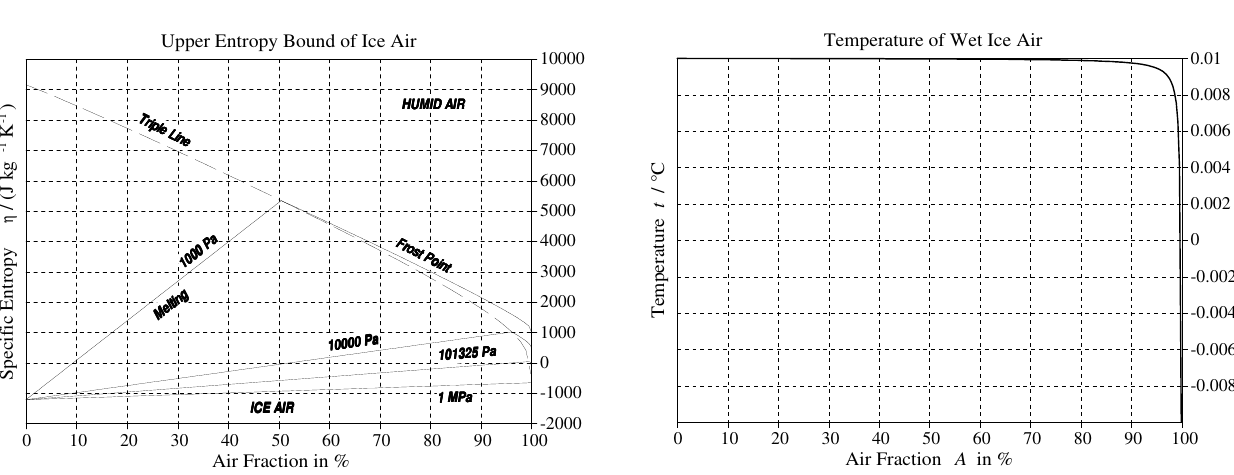
Fig. 11: Temperature of wet ice air as a function of the air fraction, T ( A ), computed as Fig. 10 Valid entropy values of ice air computed from Eq. (5.79) as arguments of enthalpy Fig. 11. Temperature of wet ice air as a function of the air fraction, Fig. 10. Valid entropy values of ice air computed from Eq. (5.79) ( ) Pwh ,, AAI η are bounded above by roof-shaped curves, depending on the air fraction w A described under case 1, Appendix A.12. (cid:16) (cid:17) T (A) , computed as described under case 1, Appendix A12. w A , η, P as arguments of enthalpy h AI are bounded above between 0 and 100% for selected pressures P as shown. At the entropy bound on the right, the ice phase is completely sublimated, given by the solution T = T subl ( P vap ) of case 2 in Appendix The independent variables in this scheme are the total pressure, P , the liquid density, ρ W , the by roof-shaped curves, depending on the air fraction w A be- A.11, and labelled “Frost Point” in the figure. At the left boundary lines radiating from the humid-air density, ρ AV , the temperature, T , and the air fraction, A . Expressing the chemical lower left portion of the figure, the ice phase starts melting, Eq. (5.5), labelled here as tween 0 and 100% for selected pressures P as shown. At the potentials in Eq. (5.83) by means of Eqs. (5.84) and (5.86), gives four equations in these five “Melting” lines. The locus of the roof tops at various pressures is the triple line, shown can still change. The two additional cases, 4 and 5, consid- unknowns so that one of the independent variables must be specified to complete the system. entropy bound on the right, the ice phase is completely sub- dashed, at which ice, liquid water and vapour coexist in the presence of air, as described in Once this is done, the remaining variables may be solved for iteratively as discussed in ered in Appendix A12 address this requirement. Sect. 5.10, Eq. (S28.8). Freezing curves were computed with the library functions limated, given by the solution T = T subl (P vap ) of case 2 in Appendix A.12. Three important cases of different initially known properties corresponding ice_liq_meltingtemperature_si and ice_air_g_entropy_si , and frost point curves were Figure 11 corresponds to case 1 in the Appendix A12 with to this system are discussed there. If the relative mass fractions of the three phases are Appendix A11, and labelled “Frost Point” in the figure. At determined using ice_air_frostpoint_si and air_g_entropy_si. For running w A , the triple required, then an additional condition is required to fix these quantities, since at constant T line is computed by calling the sequence set_liq_ice_air_eq_at_a , fixed dry air fraction, A . It illustrates that the temperature the left boundary lines radiating from the lower left portion and P the water-ice mass ratio can still change. The two additional cases, 4 and 5, considered liq_ice_air_temperature_si , liq_ice_air_pressure_si and air_g_entropy_si. in Appendix A.12 address this requirement. of wet ice air differs only very little from the triple-point of the figure, the ice phase starts melting, Eq. (5.5), labelled here as “Melting” lines. The locus of the roof tops at various temperature of water, almost independent of pressure, caus- pressures is the triple line, shown dashed, at which ice, liquid ing the adiabatic lapse rate under these conditions to be very water and vapour coexist in the presence of air, as described in small. Note that the curve shown here neglects the solubility Sect. 5.10, Eq. (S28.8). Freezing curves were computed with of air in water which could result in temperature effects of the library functions ice liq meltingtemperature si similar order. and ice air g entropy si , and frost point curves Figure 12 shows results corresponding to case 5 from Ap- were determined using ice air frostpoint si and pendix A12 in which the dry-air fraction, w A , entropy, η , and air g entropy si . For running w A , the triple line is com- the liquid fraction of the condensed part, w = w W /( w W + w Ih ) puted by calling the sequence set liq ice air eq at a , are specified. If an air parcel is lifted with the first two quanti- liq ice air temperature si , ties fixed, then w varies between 0 at the melting level (com- liq ice air pressure si and air g entropy si . pletely frozen condensate), and 1 at the freezing level (com- pletely molten condensate). Four valid wedge-shaped Wet- Ice-Air (WIA) regions are shown in this figure correspond- ing to pressures of 1000, 10 000, 101 325 and 1 000 000 Pa. Only points ( w A , η ) selected from these wedge-shaped re- gions permit valid solutions in this case. tines are listed in Table